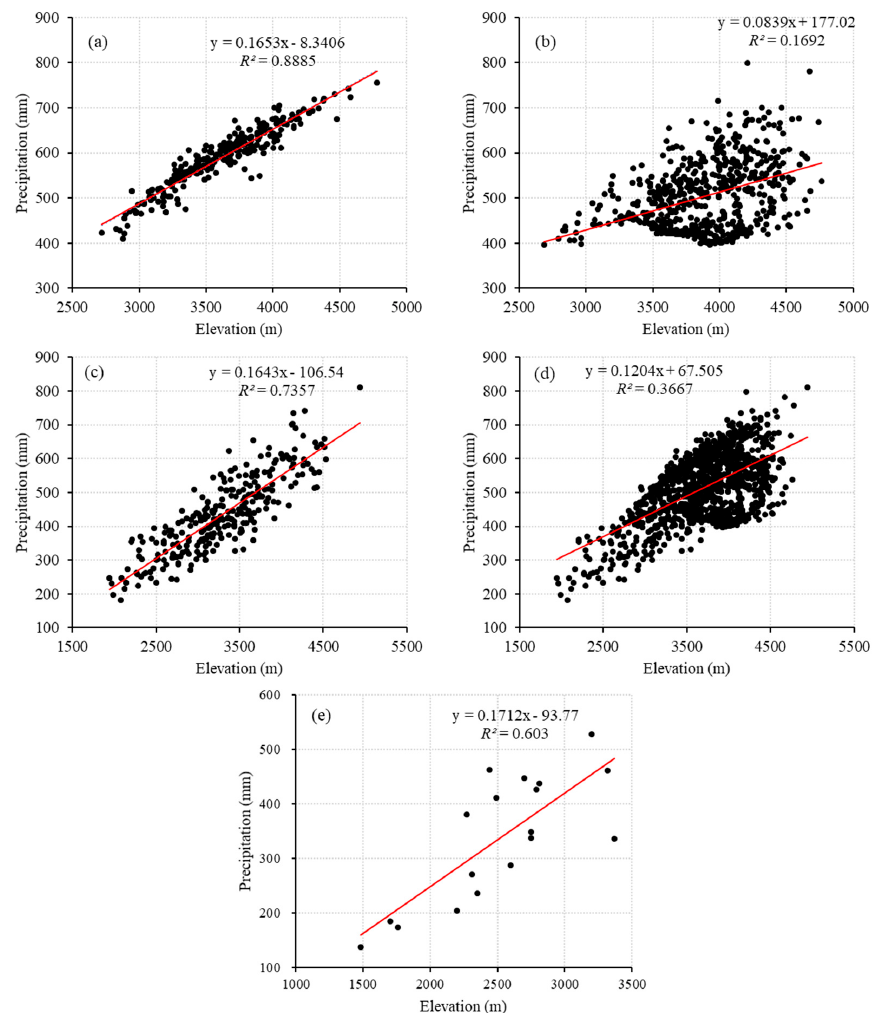
Figure 6. Scatter diagram of the gridded precipitation and its elevation in the east tributary ( a ), west tributary ( b ), mainstream ( c ), entire basin ( d ), and observations ( e